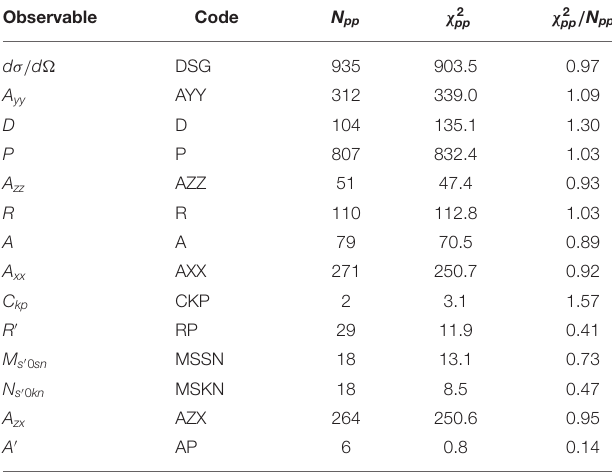
TABLE 2 | Contributions to the total χ 2 for different pp observables [60, 61].